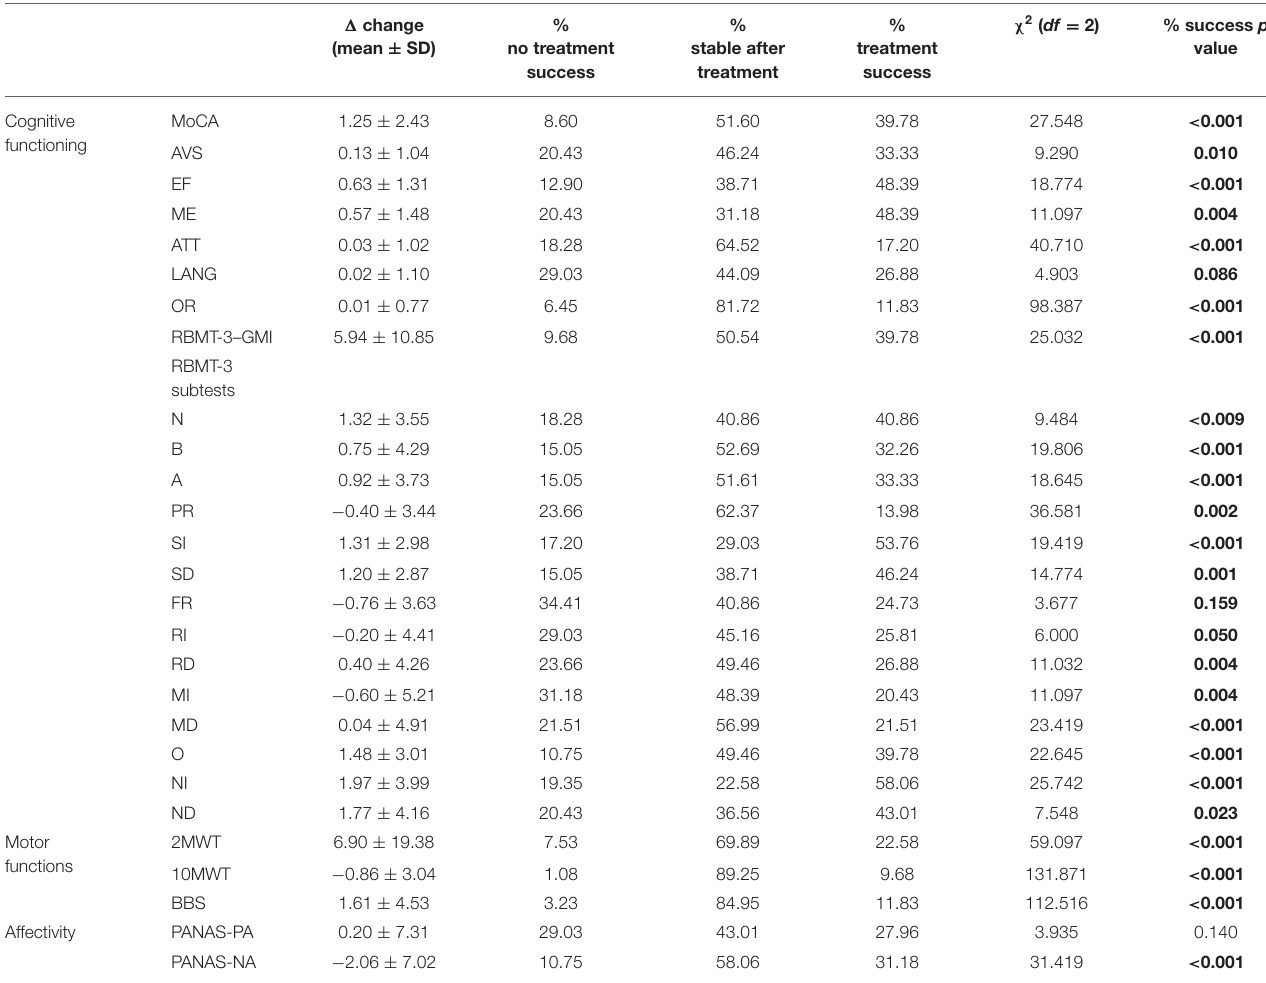
1 change (mean ± SD)